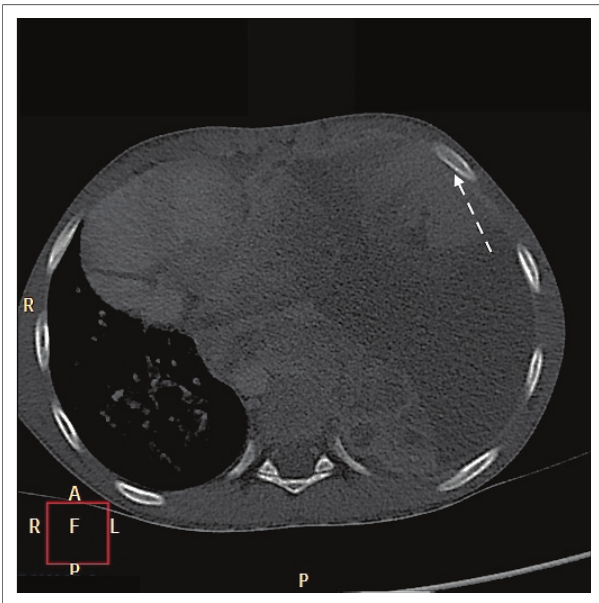
FIGURE 3: Axial computed tomography image of the chest on bone window demonstrates the absence of associated bony erosions (white